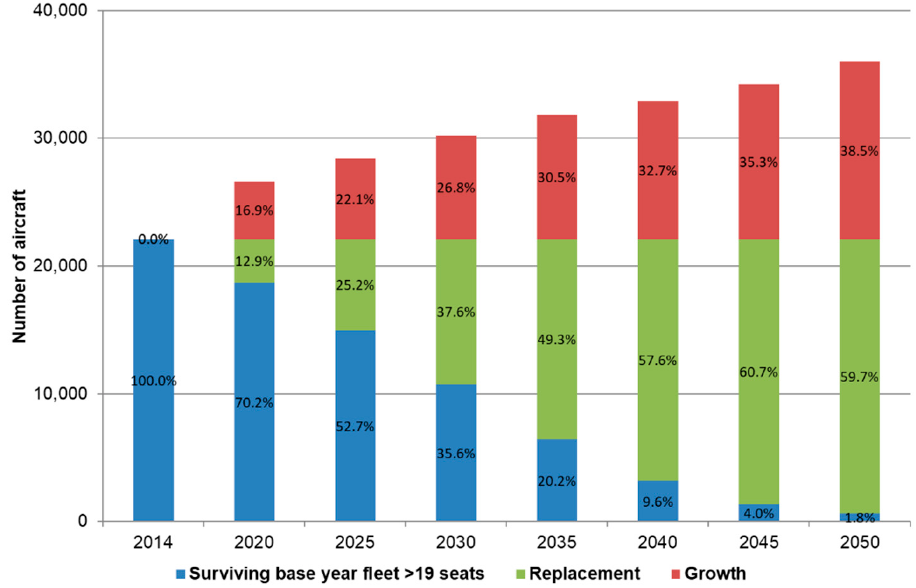
Figure 19. Passenger-in service fleet breakdown in the Low Scenario.